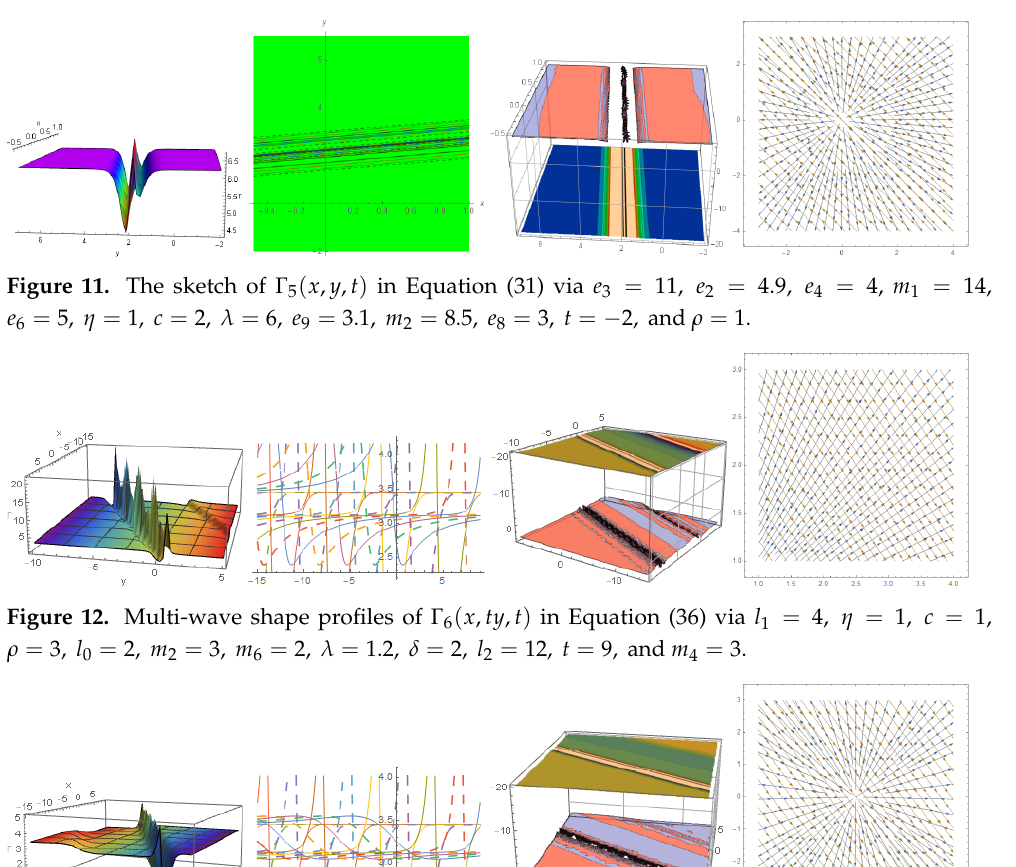
Figure 10. The pictorial representation of PCRs in Equation (31) with e 3 = 11, e 2 = 4.9, e 4 = 4, m 1 = 14, e 6 = 5, η = 1, c = 2, λ = 6, e 9 = 3.1, m 2 = 8.5, e 8 = 3, t = − 2, and ρ = 1.